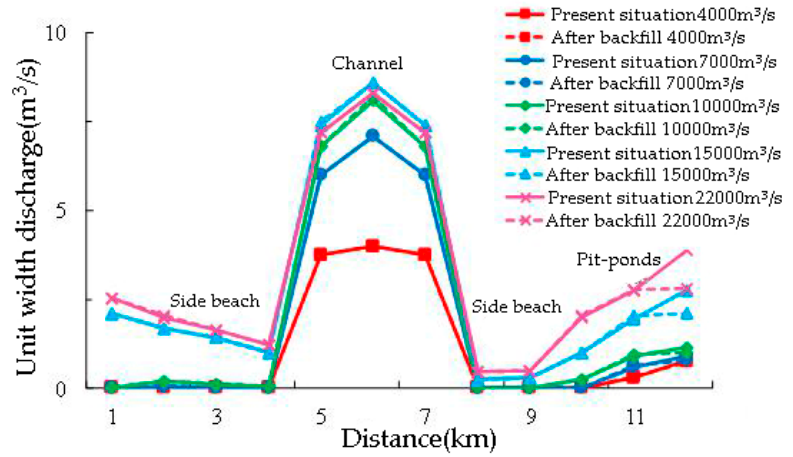
Figure 13. Single width flow distribution of the 172 cross-section.